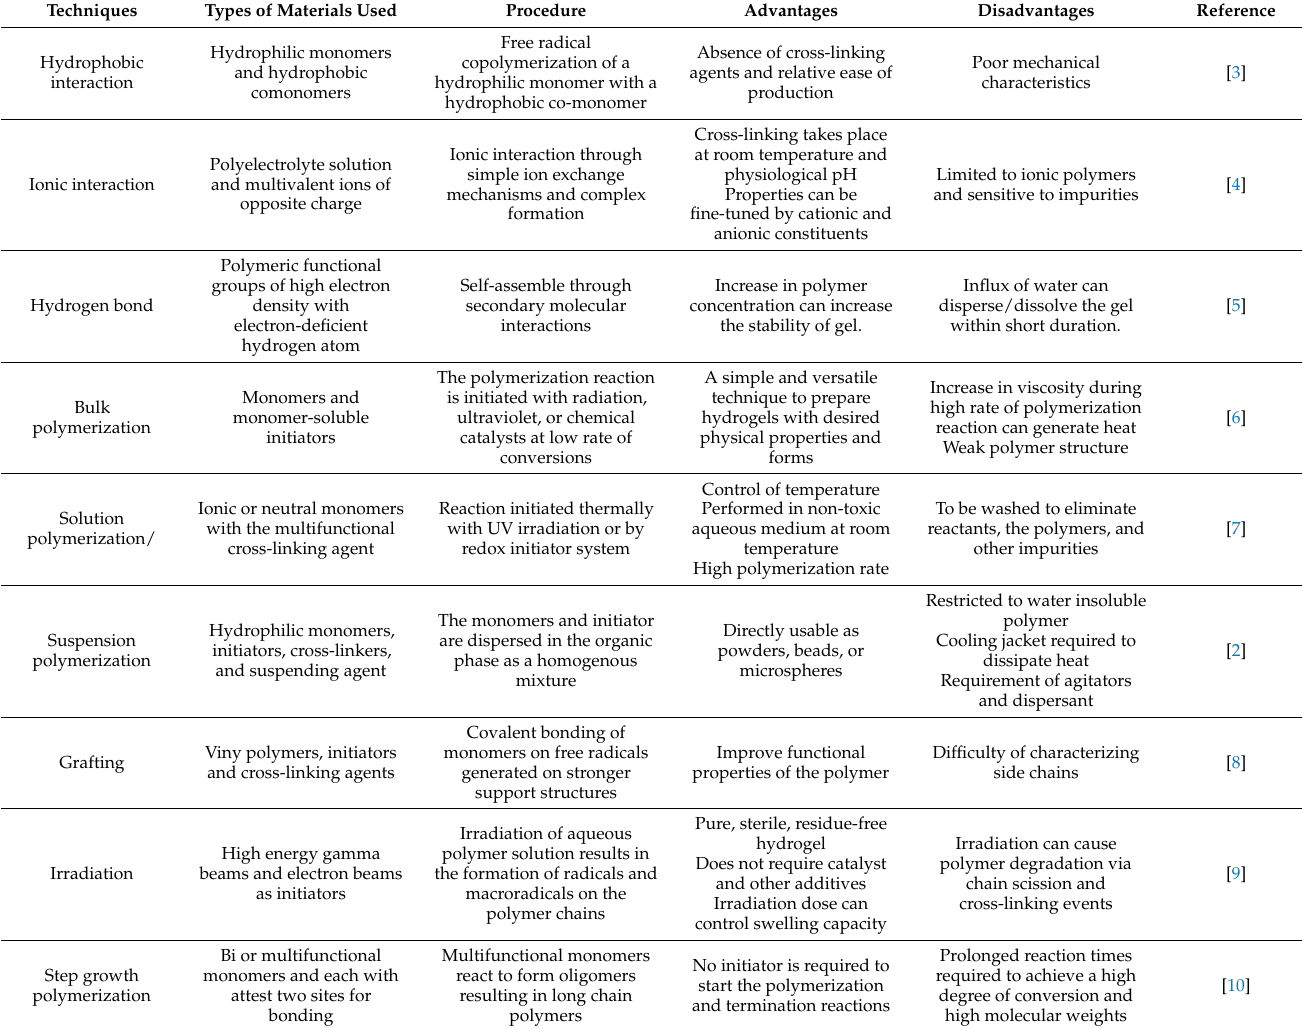
Table 1. Different techniques, materials, procedures, advantages, and disadvantages of hydrogels.